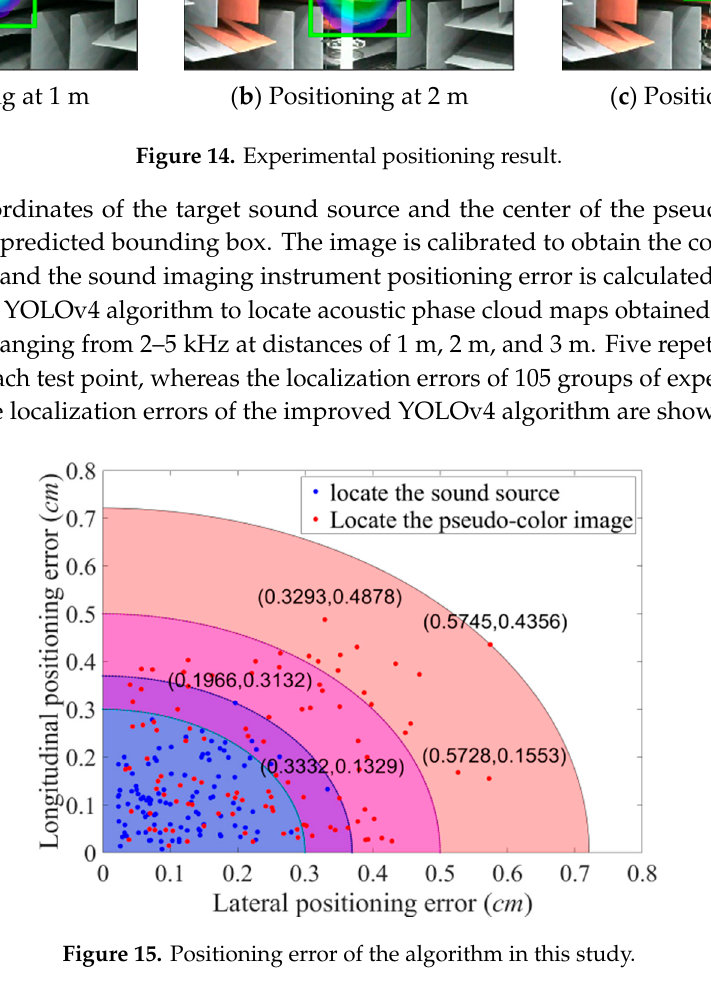
Figure 15. Positioning error of the algorithm in this study.